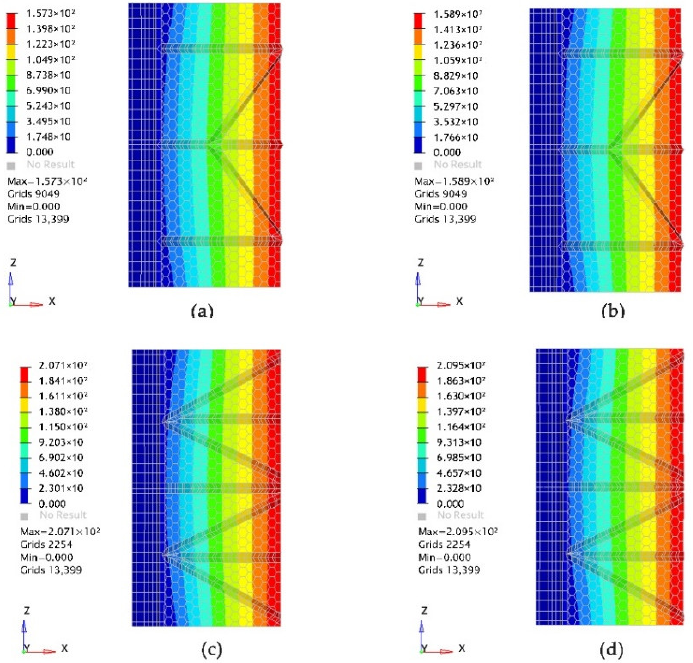
Figure 25. ( a ) Linear combined displacement analysis of carport I model under the G k + Q W load; ( b ) Nonlinear combined displacement analysis of carport I model under the G k + Q W load; ( c ) Linear combined displacement analysis of carport II model under the G k + Q W load; ( d ) Nonlinear combined displacement analysis of carport II model under the G k + Q W load.